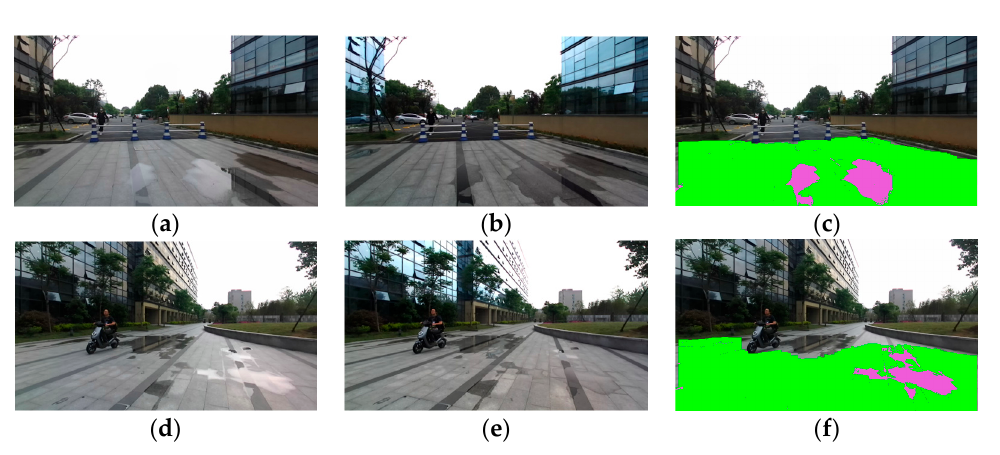
( i ) Figure 7. Farthest traversable lines with or without water hazard detection. ( a , d , g ) Traversable area and water hazard detection results; ( b , e , h ) Farthest traversable lines correspond to the traversable area detection without water hazard detection; ( c , f , i ) Farthest traversable lines obtained with both traversable area detection and water hazard detection.